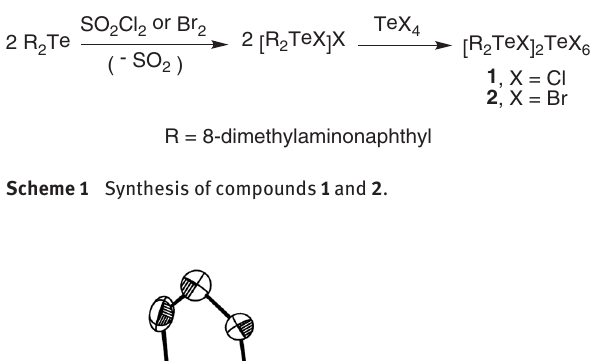
Figure 1 Molecular structure of [(8-Me showing 30% probability ellipsoids and the crystallographic num- bering scheme.